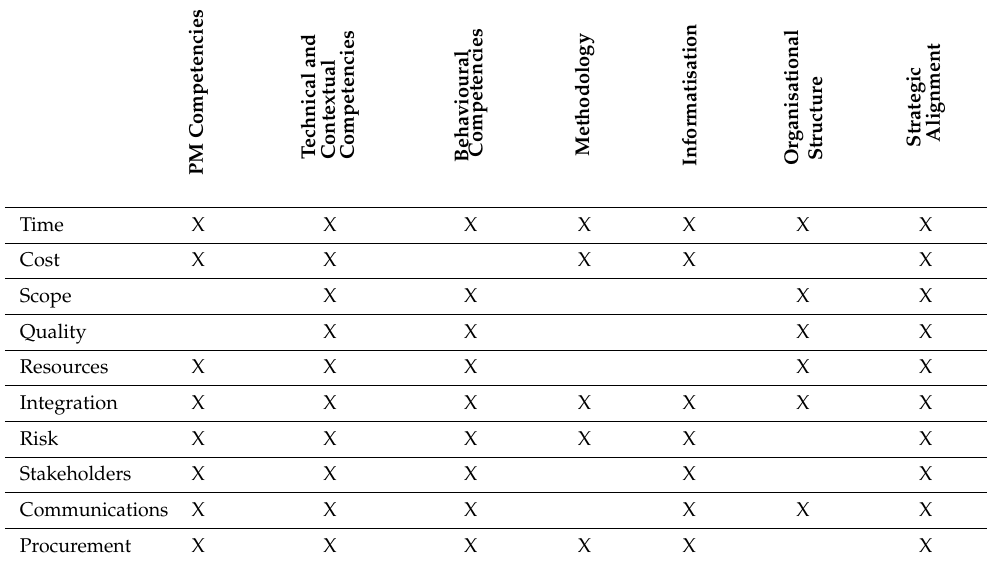
Table 2. Cross between PMBOK ® Guide—Fifth Edition 10 knowledge areas and the MMGP-Prado seven